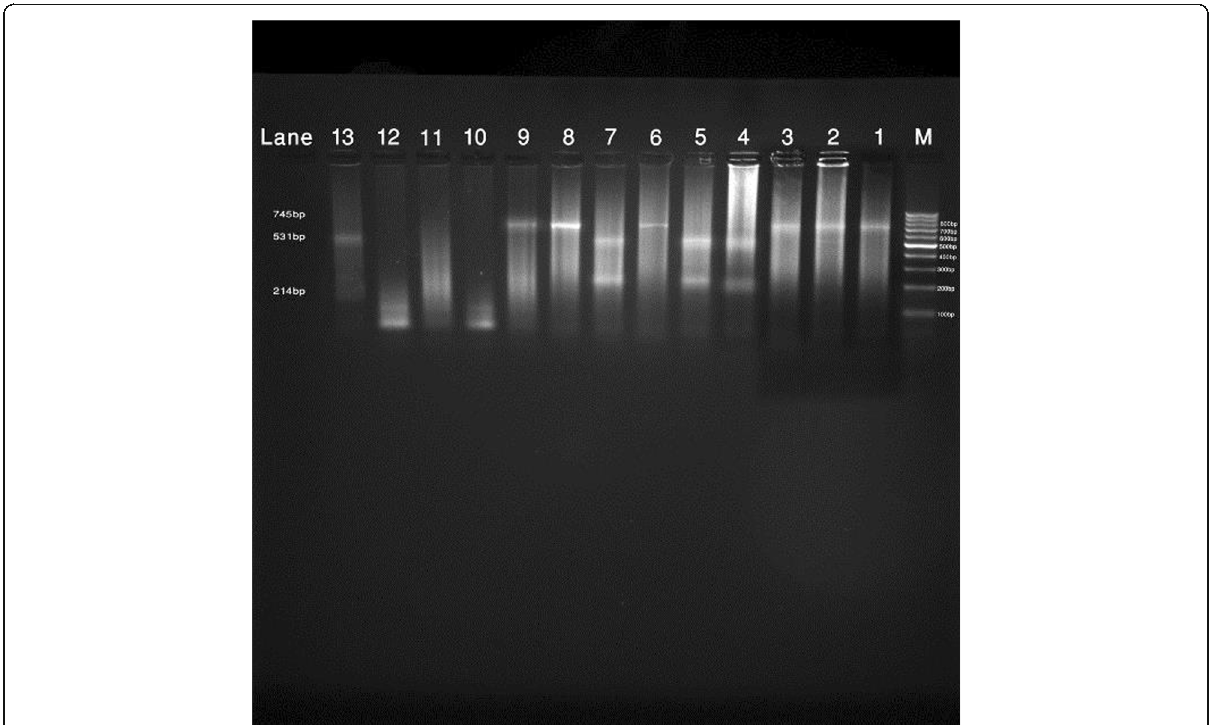
Fig. 1 Representative gel picture showing the PCR-RFLP analysis of ApaI VDR gene polymorphism on ethidium bromide-stained 2% agarose gel. M, marker (100 bp DNA ladder); lanes 4, 5, and 7 represent homozygous polymorphism (CC genotype; 531 and 214 bp bands); lanes 1, 2, 3, 6, 8, 9, and 13 represent no polymorphism (AA genotype; 745 bp